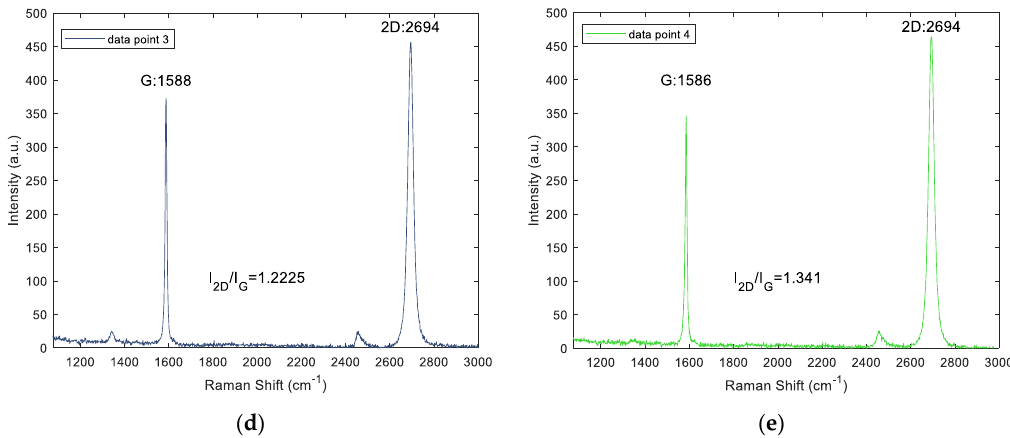
Figure 6. Raman spectra of monolayer graphene used for experimental studies ( a ) Locations of data points on graphene sample used for Raman scanning ( b – e ) Measured spectra for the locations of data points.